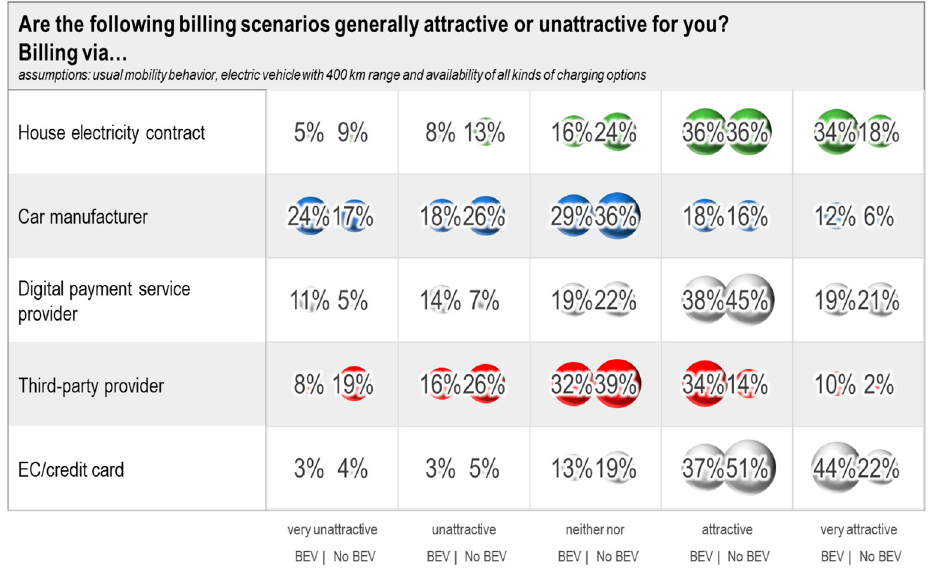
Figure 10. Attractivity of different billing models ( n = 1151; own diagram based on [9]).